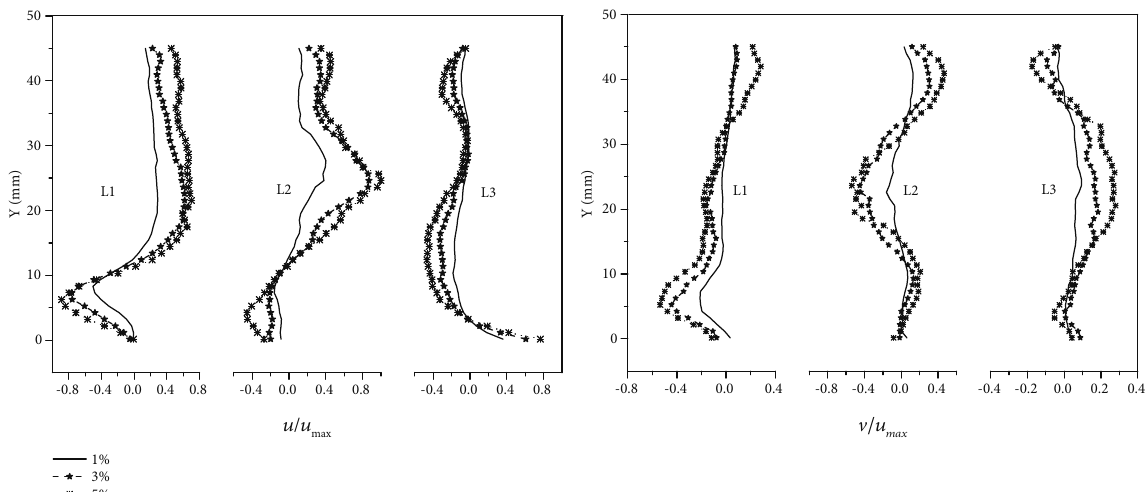
Figure 6: Distribution patterns of u and v at di ff erent axial positions.